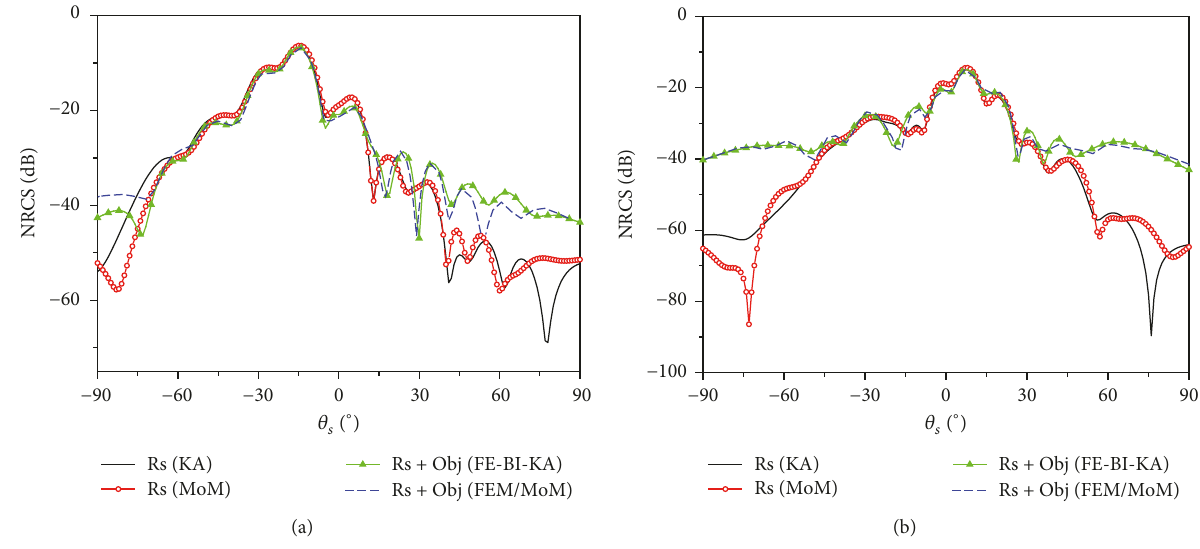
Figure 5: Bistatic NRCS of a 3D inhomogeneous sphere buried under dielectric rough surface: (a) 𝑋 - 𝑍 Plane and (b) 𝑌 - 𝑍 Plane.